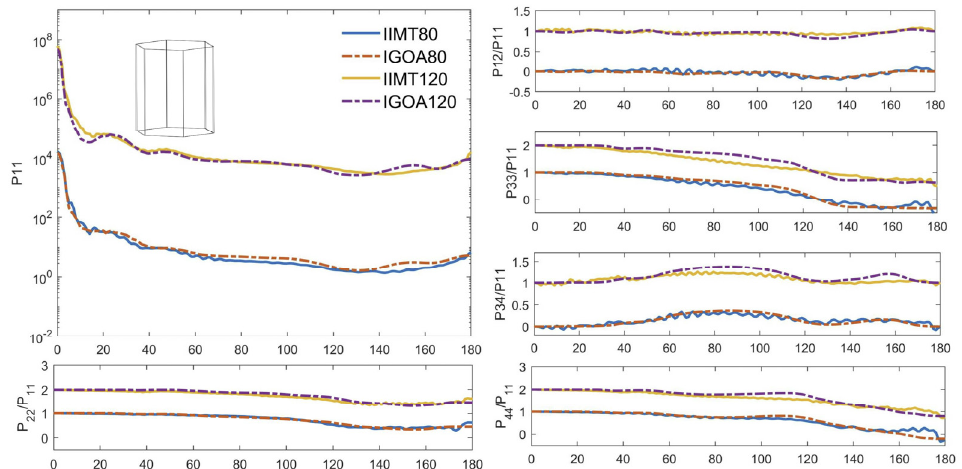
Figure 11. Comparison of four phase matrix elements computed from the IGOA and the II − TM for hexagonal prism particles. The particle size parameters for curve pairs from lower to upper are 80, 120. For clarity, the phase functions of 120 are multiplied by 1000, P 12 /P 11 , P 22 /P 11 , P 33 /P 11 , P 44 /P 11 and P 34 /P 11 of 120 are shifted by 1. The solid line is the IIM T-matrix model and the dashed is IGOA model.